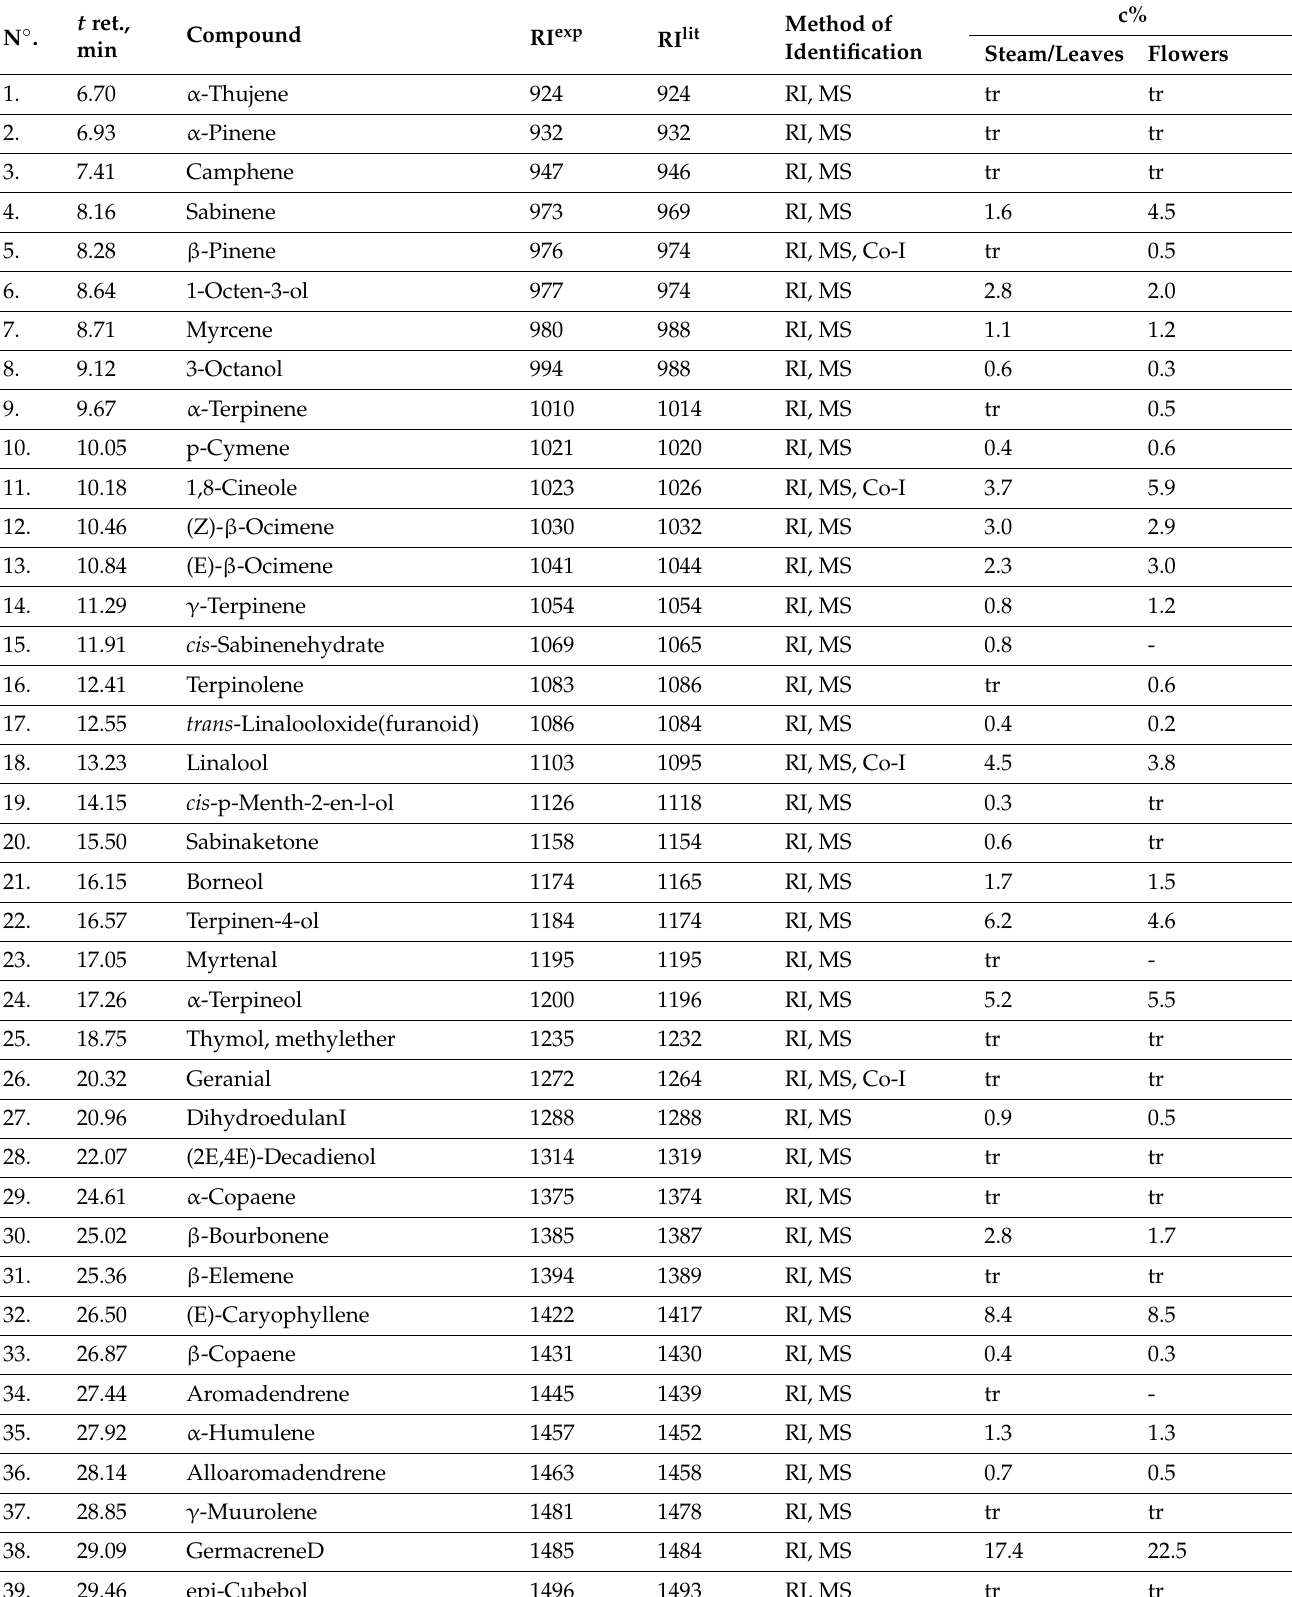
Table 5. Chemical composition of essential oil isolated from wild oregano (stems/leaves and flowers).